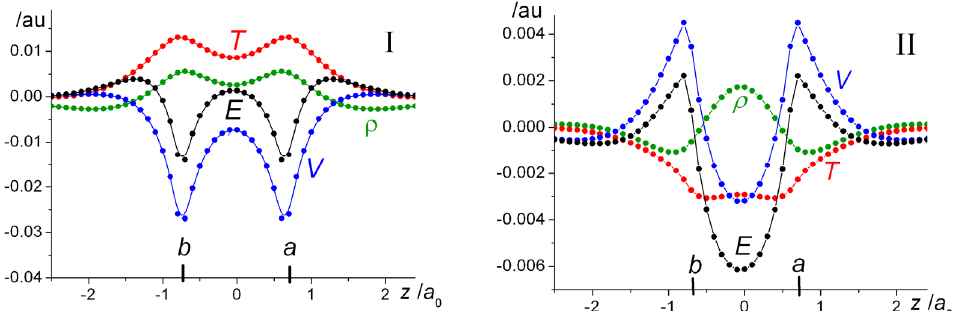
Figure 8. Panel I: Molecular contraction at R = 1.4 a 0 , i.e., di ff erence maps of integrated densities ( ρ ) and kinetic ( T ), potential ( V ) and total energies ( E ) between H 2 with ζ opt = 1.1695 and ζ = 1.0. Total energy changes ( / E h ): ∆ T = 0.3007, ∆ V = − 0.3342, and ∆ E = − 0.0336. Panel II: Di ff erence between molecular and atomic contractions at R = 1.4 a 0 (as defined by Equation (21)). Total energy di ff erences ( / E h ): ∆∆ T = − 0.0670, ∆∆ V = 0.0048, and ∆∆ E = − 0.0623. Comparison of the effects of contraction in the molecule with those in the free atoms (Figure 8, Panel II) shows that there is a substantial increase in the interatomic region and a corresponding decrease in the kinetic energy of the molecule. The drop in potential energy is however more than cancelled by the increase in the intra ‐ atomic region, resulting in a net antibonding contribution.